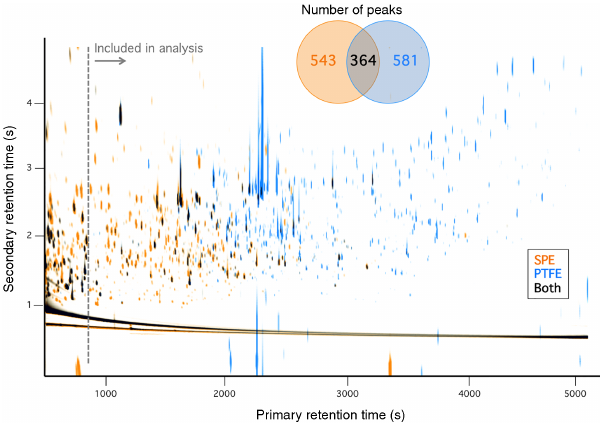
Figure 2. Overlay of composite chromatograms for all SPE and all PTFE smoke samples. Inset shows the number of peaks observed on each filter